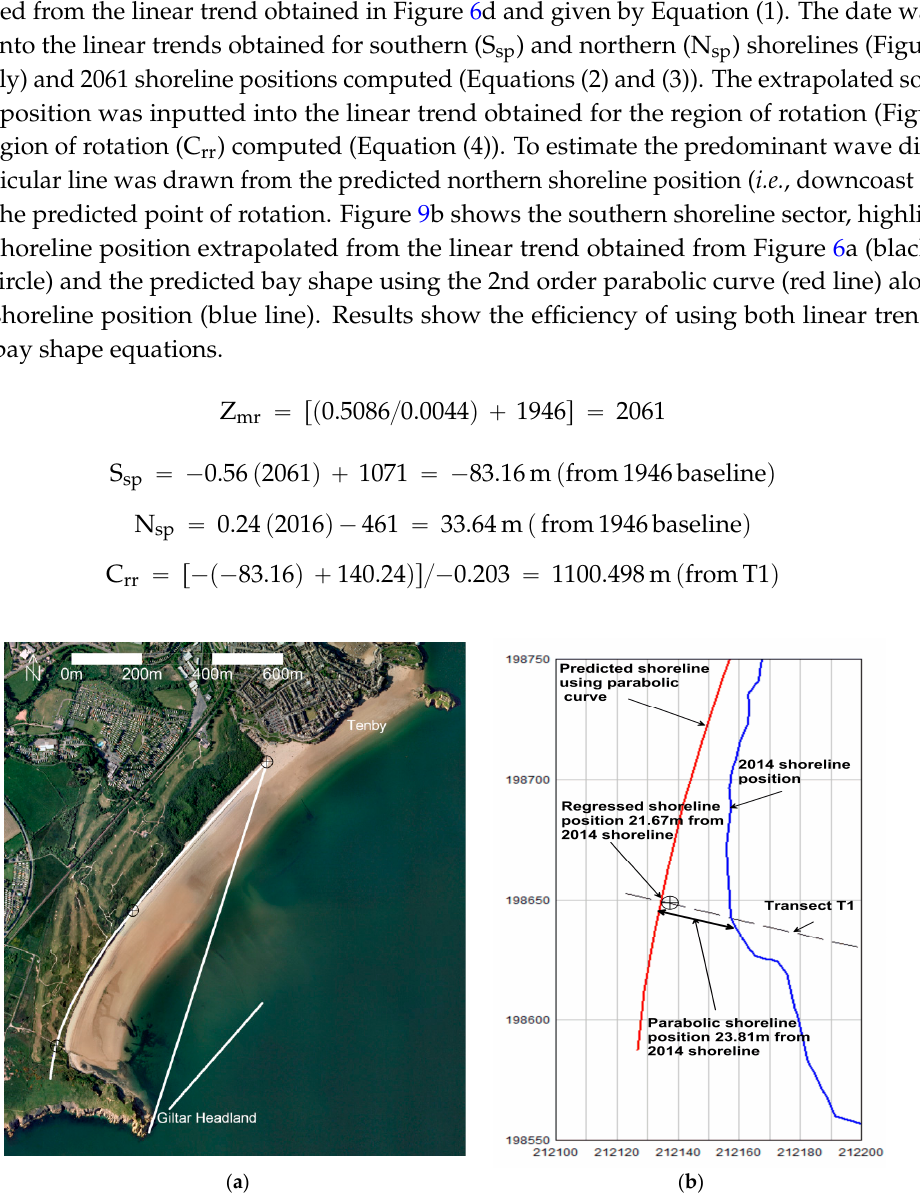
Figure 9. Equilibrium bay shape assessment using, ( a ) a parabolic curve fitted to the predicted downcoast and pivot point control points and superimposed upon the 2014 aerial photograph and ( b ) a comparison between the regressed and parabolic prediction of the equilibrium southern shoreline position in